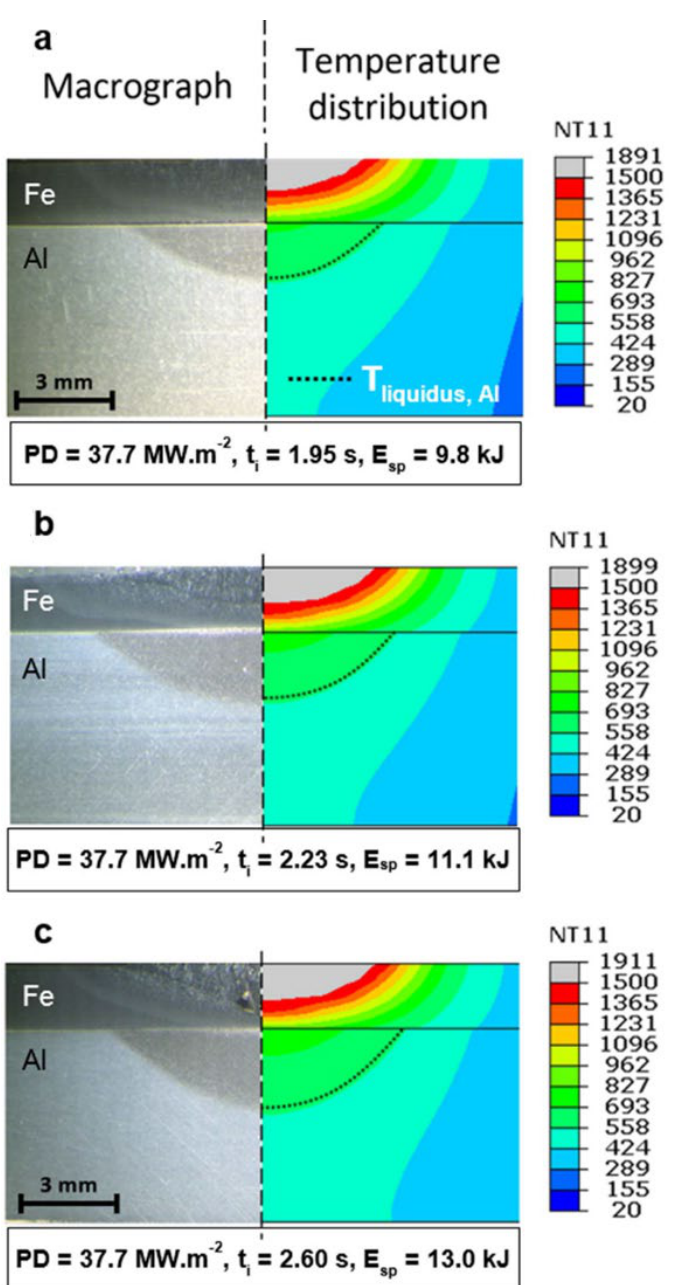
Figure 7. Comparison between the experimental and the FEM results: ( a – c ) macrograph vs. thermal profile. Reprinted with kind permission of Elsevier 2017 from Reference [28]. profile. Reprinted with kind permission of Elsevier 2017 from Reference